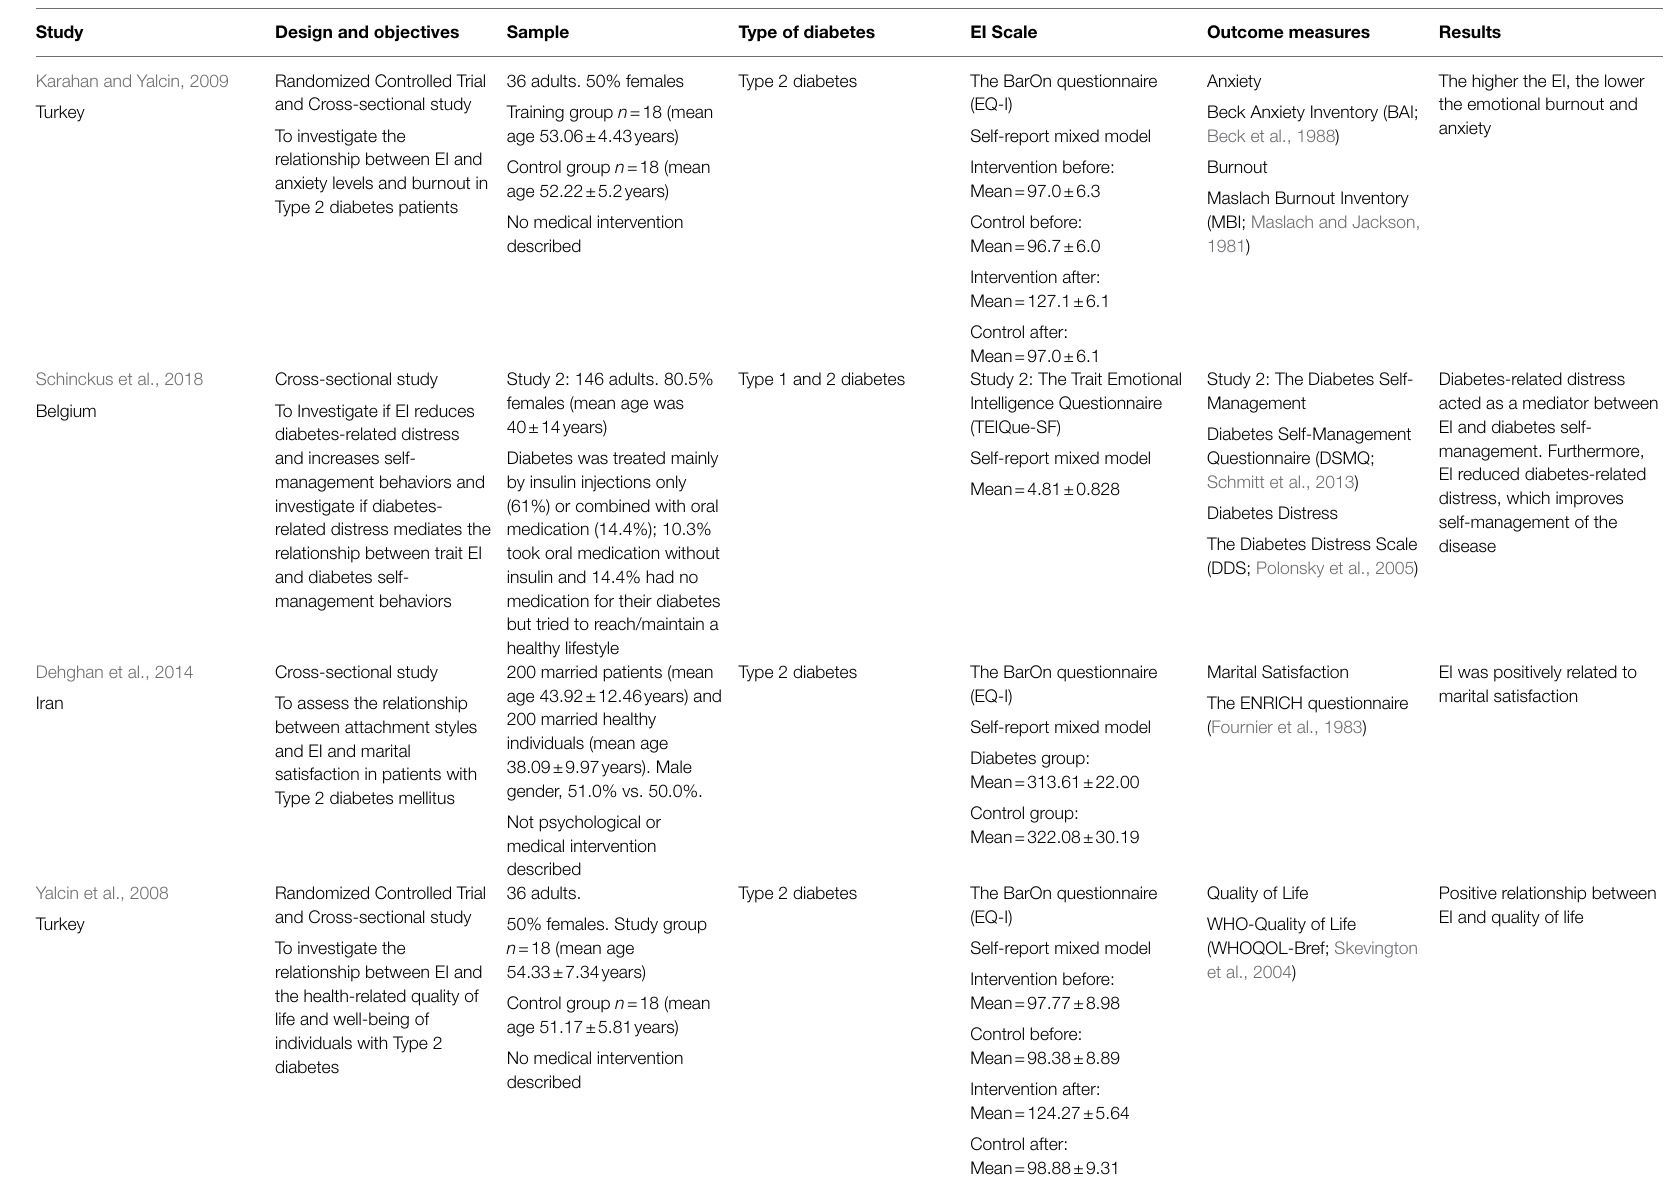
TABLE 5 | Studies analyzing the relationship between EI and psychological adjustment and